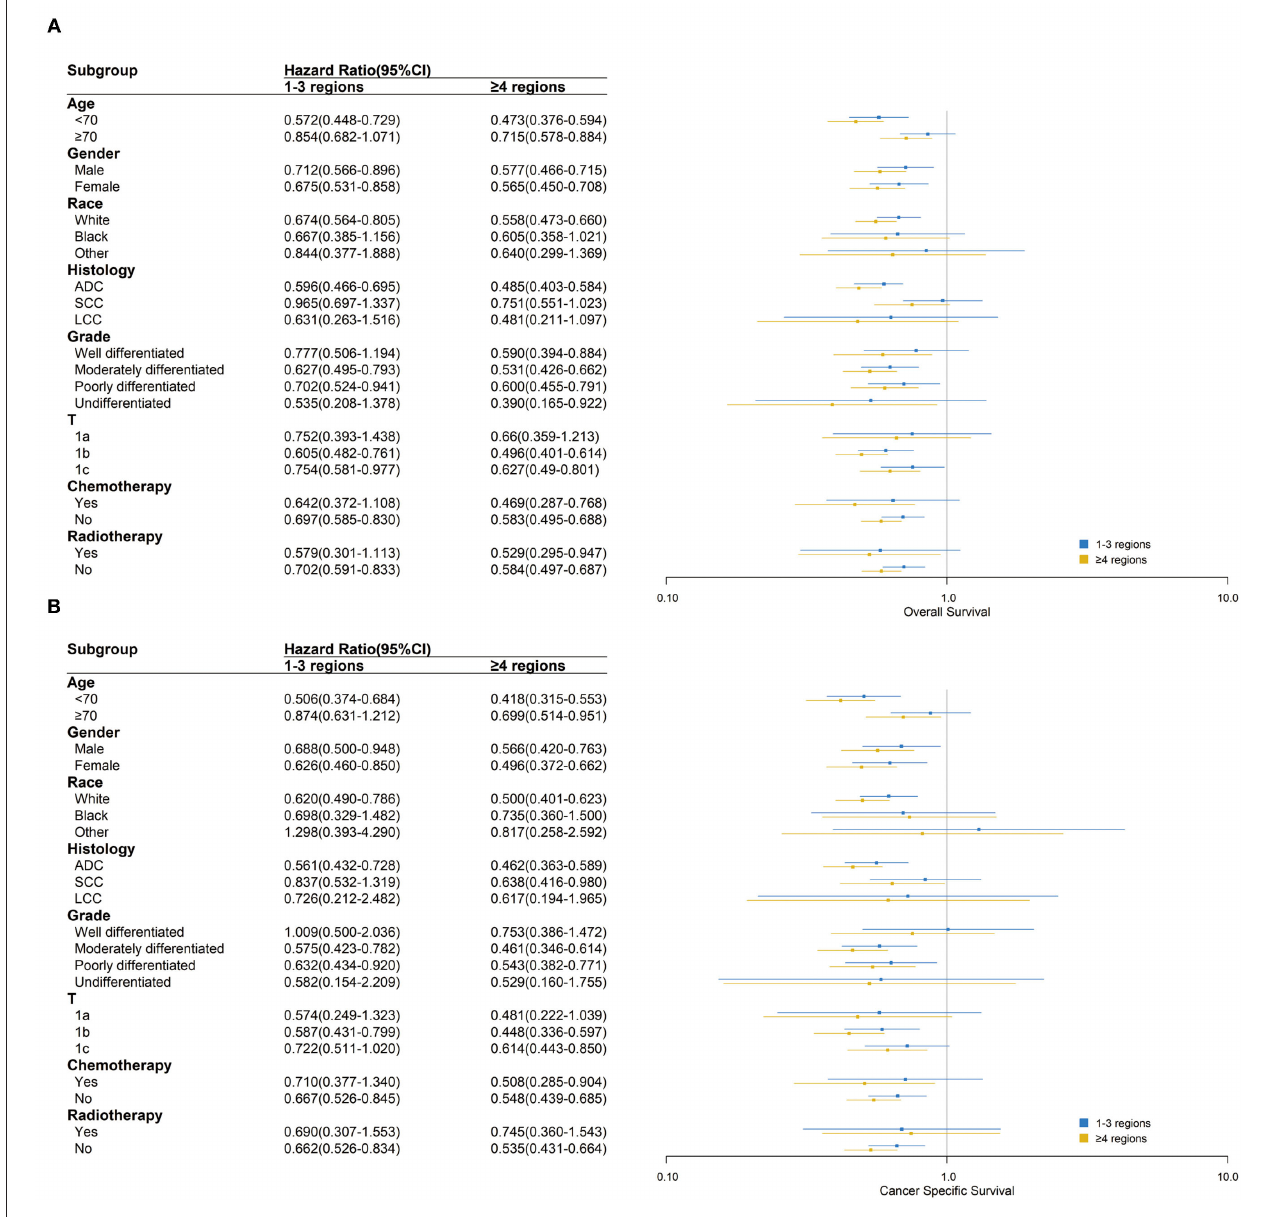
FIGURE 4 | Over survival (A) and cancer-specific survival (B) comparison among 0, 1–3 and ≥ 4 regions lymph nodes removed in different clinicopathological subgroups analysis. Blue and yellow boxes represent the HRs of 1–3 and ≥ 4 regions lymph nodes removed, respectively. The lines represent the 95% CI of the hazard